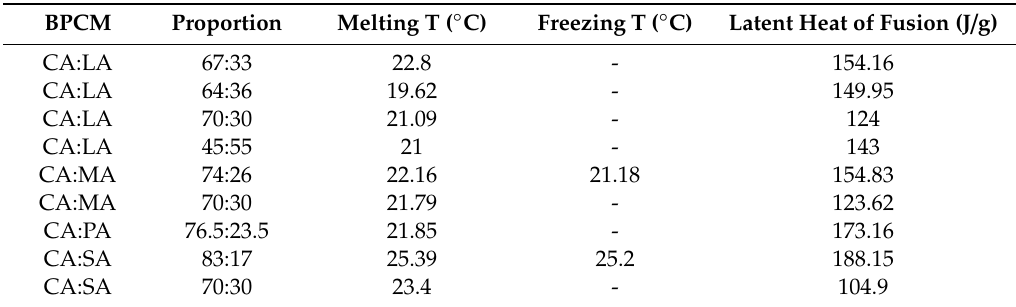
Table 2. Properties of eutectic mixtures of fatty acids suitable for the building application [2,4,22,38,39].